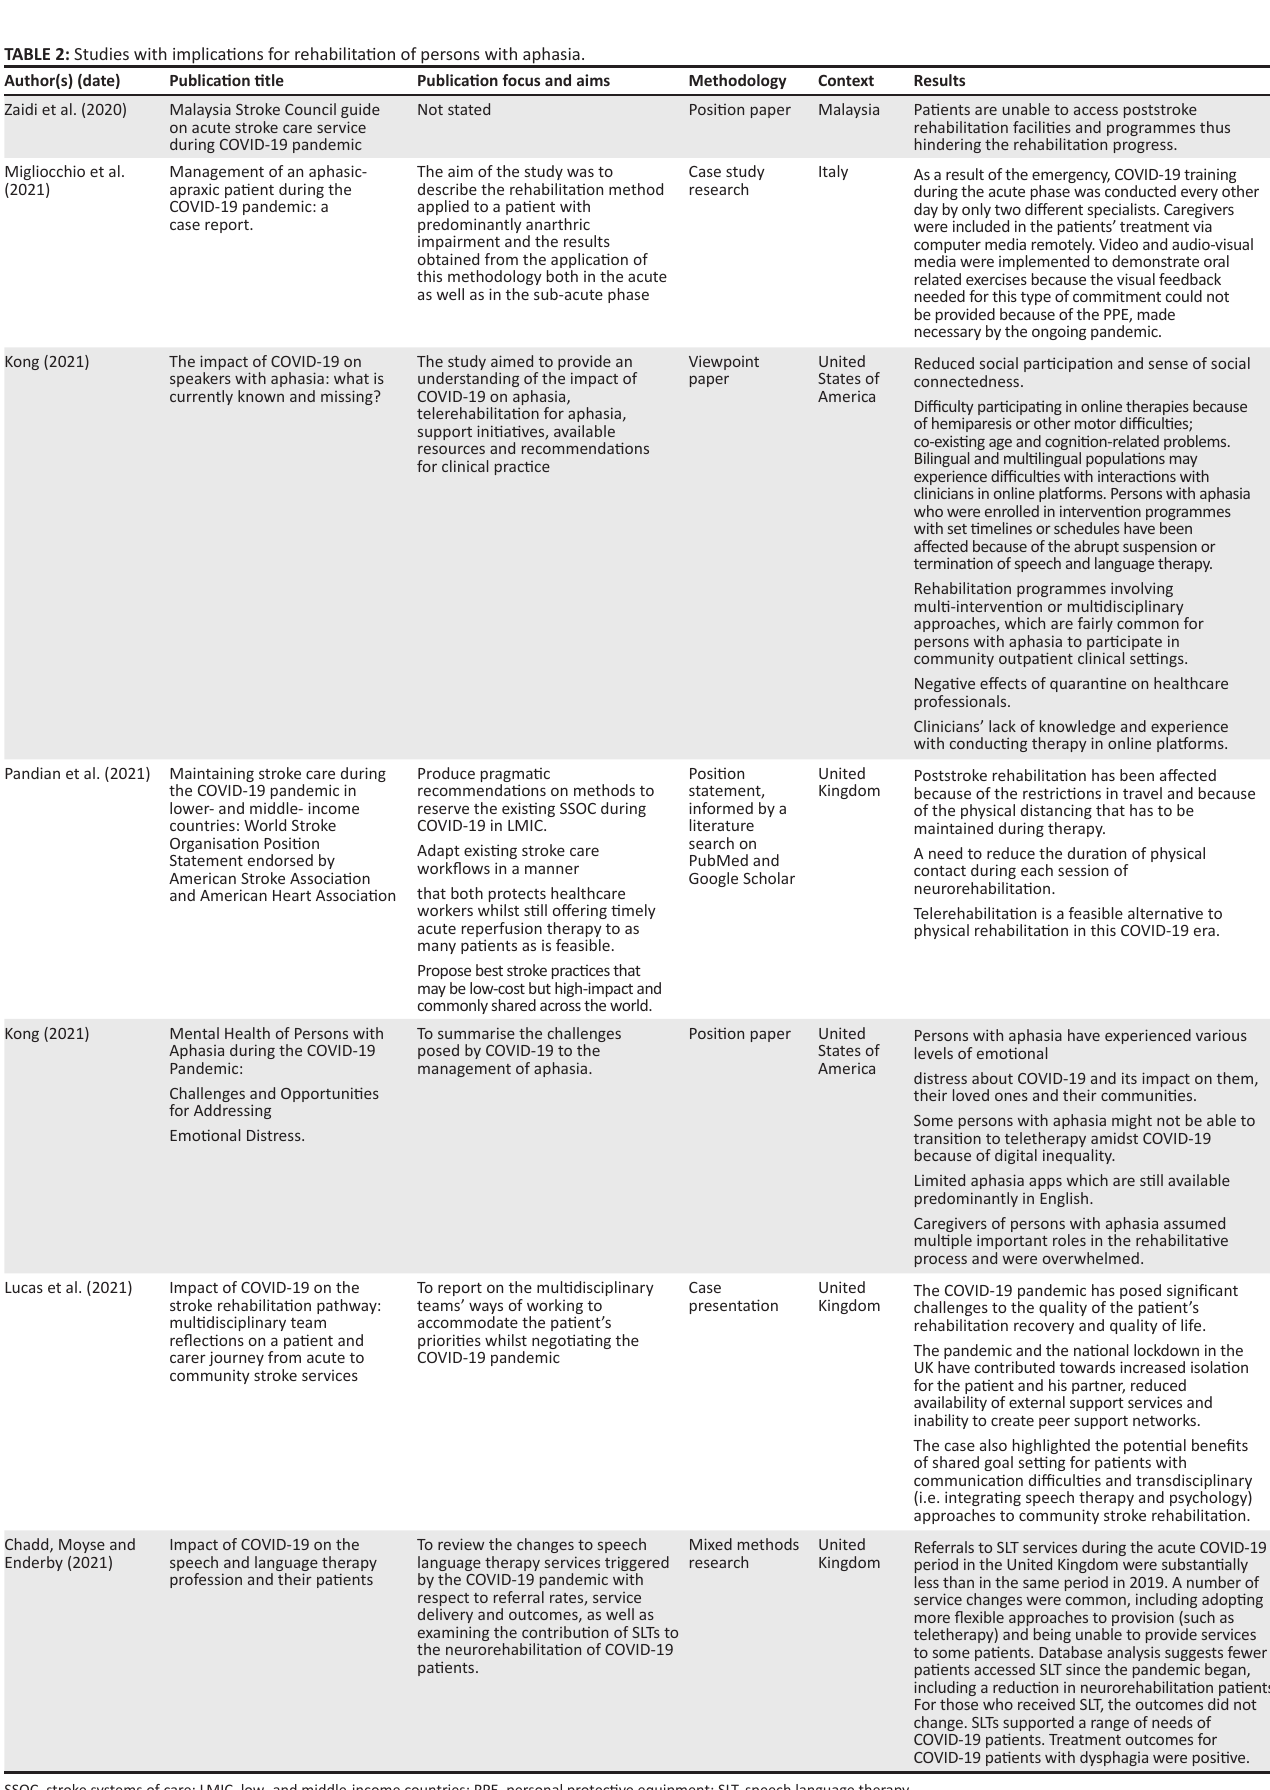
TABLE 2: Studies with implications for rehabilitation of persons with